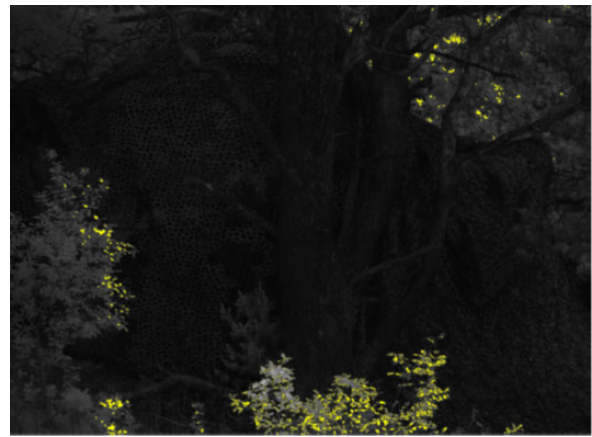
Figure 6. Results of the gradient filter; in yellow background pixels that were masked out.